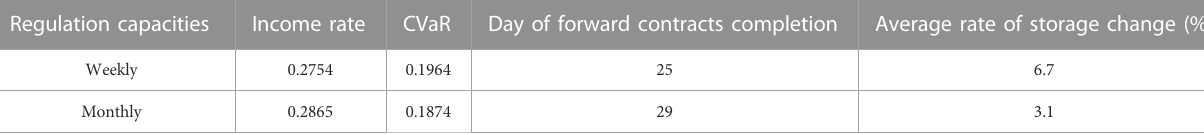
TABLE 4 Portfolio performance comparison with different regulation capacities.